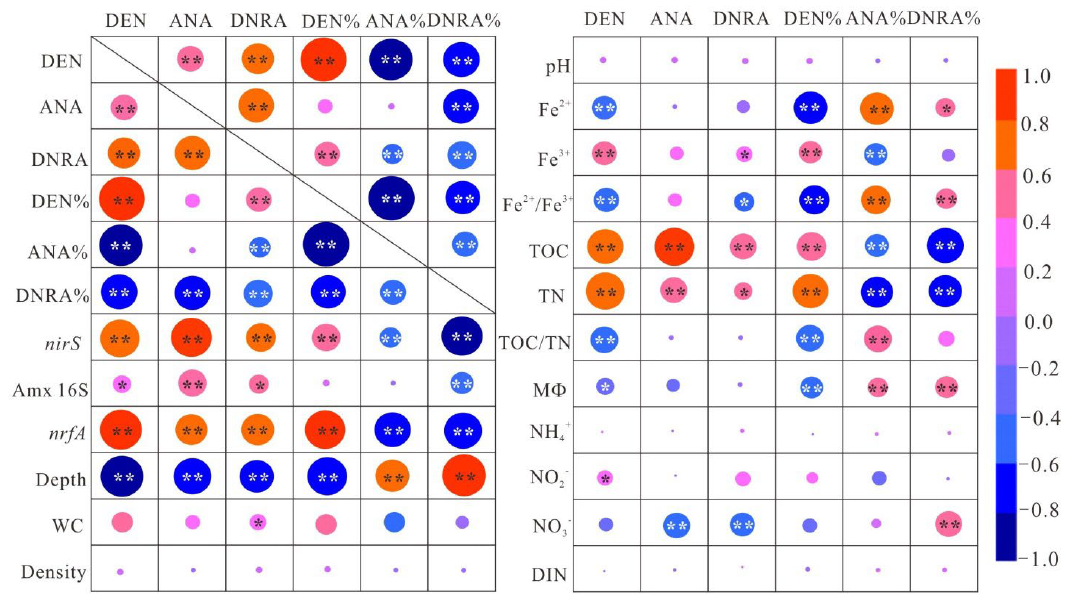
Figure 3. Pearson’s correlation analyses between NO x − reduction processes with environmental variables. * Significant at p < 0.05. ** Significant at p < 0.01. DEN, ANA, WC, MФ , and DIN mean denitrification rate, anammox rate, sediment water content, sediment median grain size, and dissolve inorganic nitrogen, respectively.